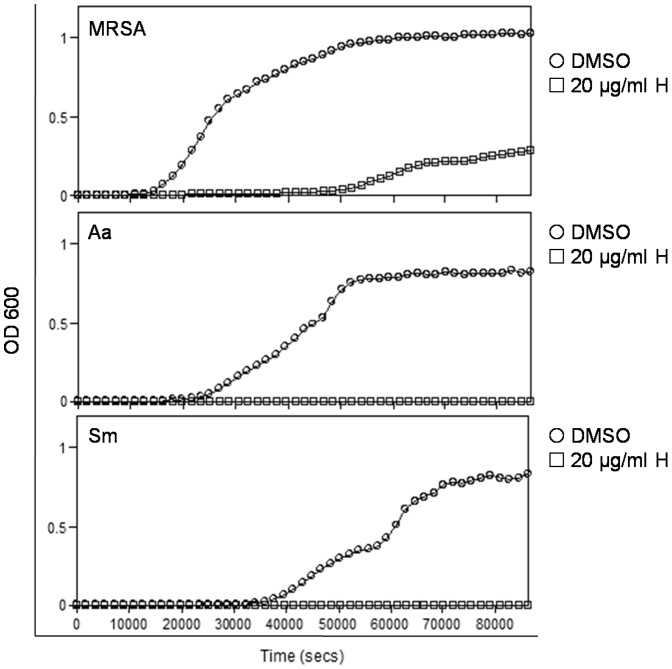
Hinokitiol inhibited oral bacterial growth.Bacterial growth curves after hinokitiol treatment for 24A. actinomycetemcomitans (Aa), and S. mutans (Sm). The y-axis is OD 600, and the x-axis is time (secs). Vehicle (0.1% DMSO) and 20 µg/mL hinokitiol (20 µg/mL H) were tested. Three independent experiments were performed in triplicate.